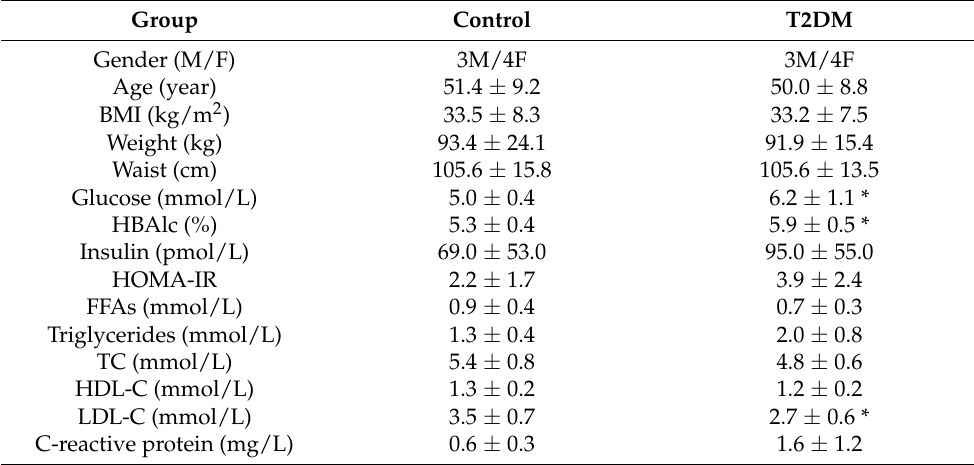
Table 1. Baseline characteristics of participants. Group Control